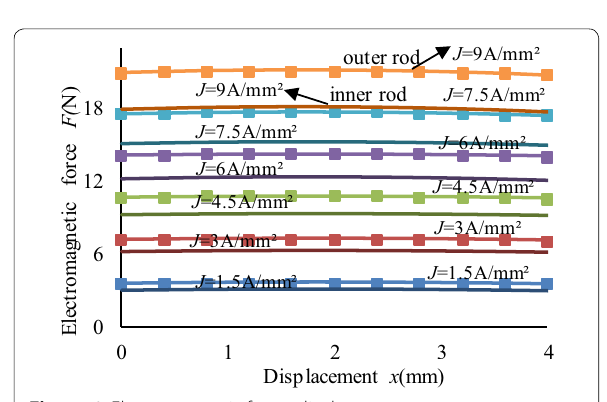
Figure 6 Electromagnetic force–displacement